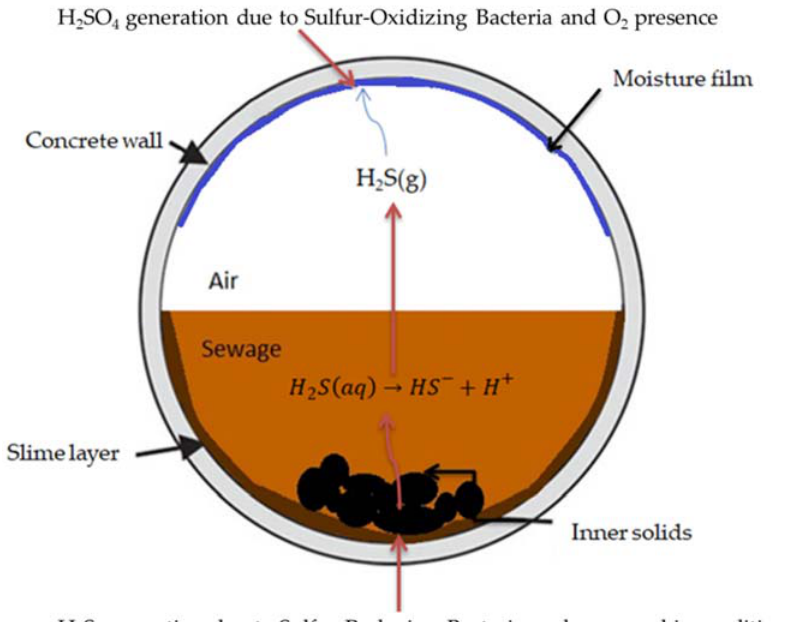
Figure 1. Cross-section representation of a concrete sewer pipe. Reproduced from Ref. [5] 2020, MDPI.